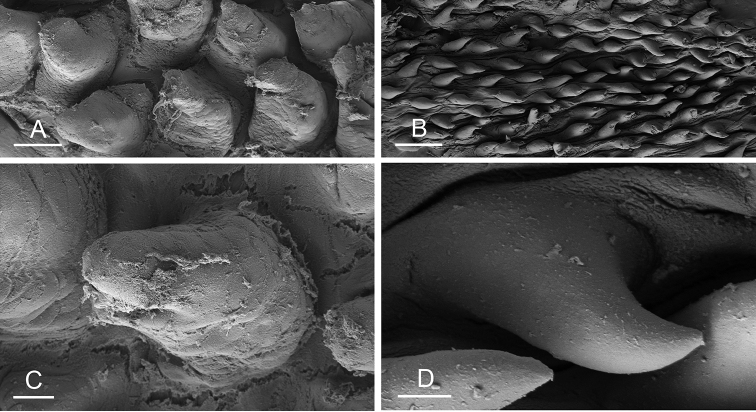
Penial hooks, Peronia
plateiA, C Hawaii, Oahu [6161] (BPBM 284528) B, D Papua New Guinea, Madang [5412] (MNHN-IM-2013-13351). Scale bars: 40 μm (A), 20 μm (B), 10 μm (C), 2 μm (D).